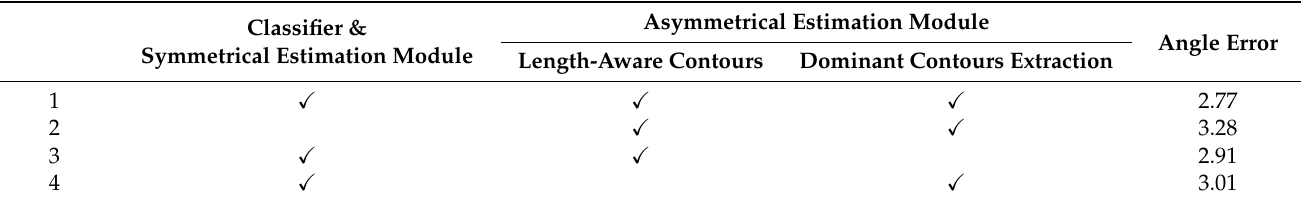
Table 4. Mean angle error with different individual components of PE-HL-PF (deg).